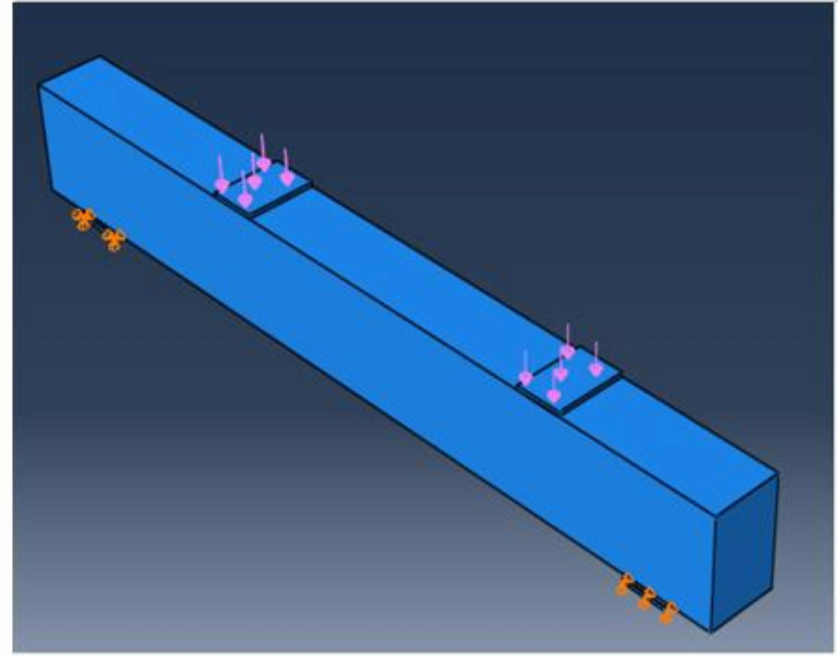
Figure 11. Loading and boundary conditions of analyzed beam.